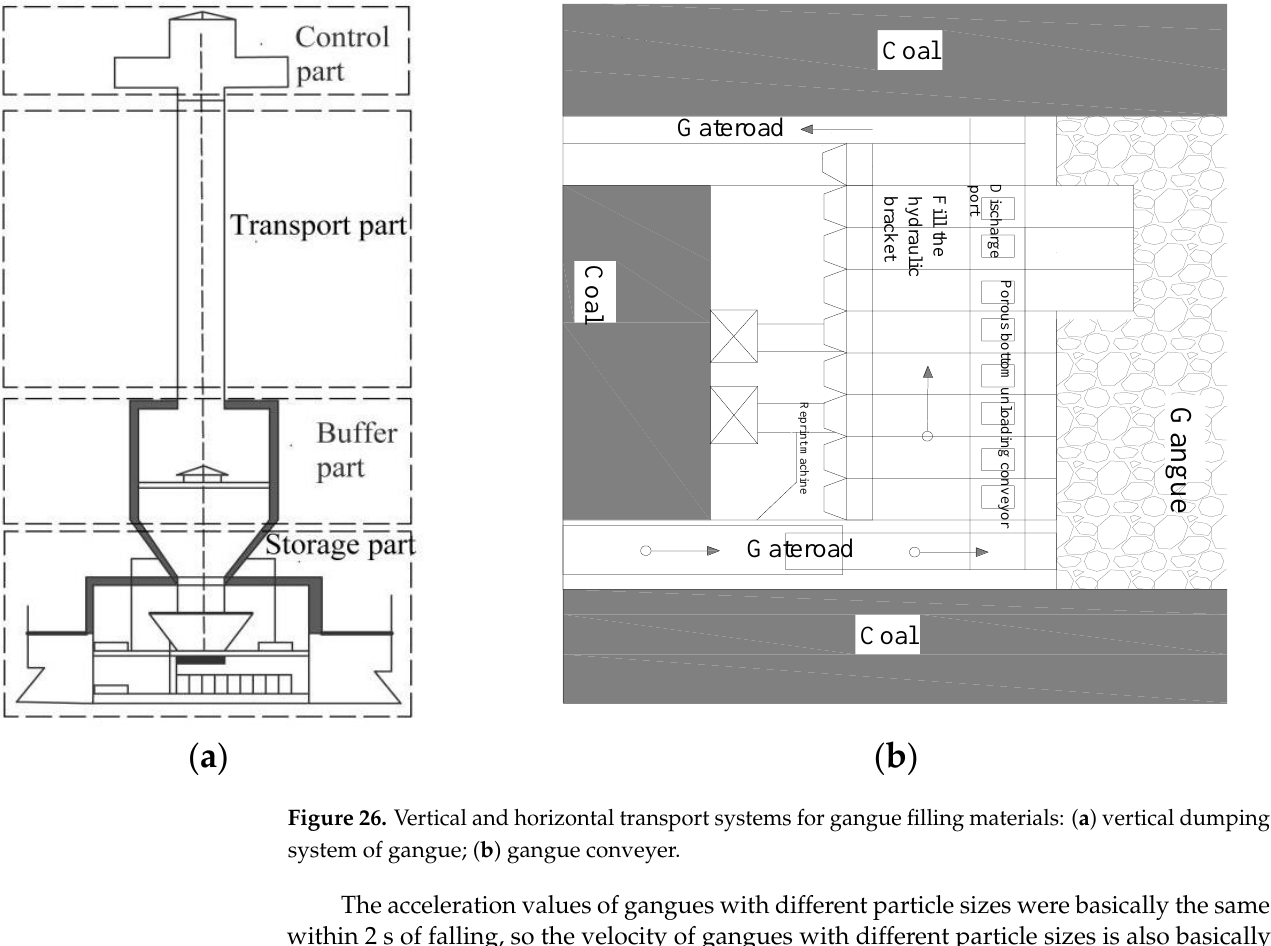
( b ) Figure 27. ( a ) The relationship between grain sizes of gangue; ( b ) running speed and time in the vertical pipeline. 3.1.3. Activation of the Gangue Backfilling Material Gangue is a granular material, and its deformation under load mainly comes from two aspects: on the one hand, the deformation of gangue particles themselves and, on the other hand, the closure of gaps between gangue particles. The latter usually accounts for a larger proportion than the former. Therefore, the compactness of the gangue filling ma- terials is the most important factor affecting its bearing performance [101,102]. The com- pactness of the gangue filling material (D) is mainly regulated in the following two ways. Controlling the grain gradation of gangue filling materials: In 2010, Wang et al. stud- ied the influence of the gangue particle size on its bearing capacity through a consolida- tion experiment. It was found that gangue particles with a large particle size were easily crushed at the edges and corners, and the small particles generated would fill the gaps between the large particles, leading to gangue filling materials with a large particle size